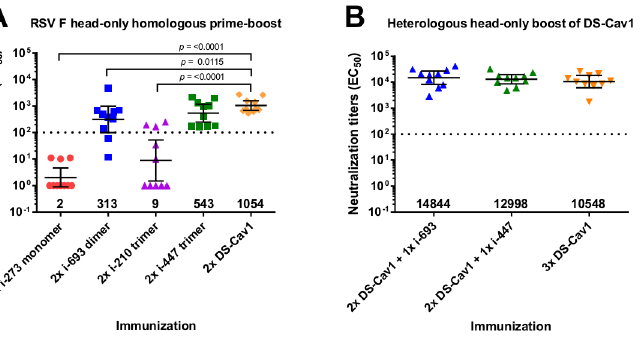
Fig 4. Head-only RSV F immunogen boost elicits neutralization titers surpassing DS-Cav1. (A) All four immunogens were used to immunize mice two times, resulting in high neutralization titers for i-693 and i-447 above the protective threshold of 100 (dotted line). P values between i-447 and i-210 or i-273 were 0.001 and < 0.0001 respectively and those between i-693 and i-210 or i-273 were 0.0014 and < 0.0001 respectively. (B) Immunogens i-693 and i-447 were used to boost DS-Cav1 seven weeks later resulting in titers higher than a DS-Cav1 homologous boost. Scatter plots show the geometric mean (numerical value below) with error bars representing the 95% confidence level. P values were determined by two-tailed Mann-Whitney tests. Each group included 10